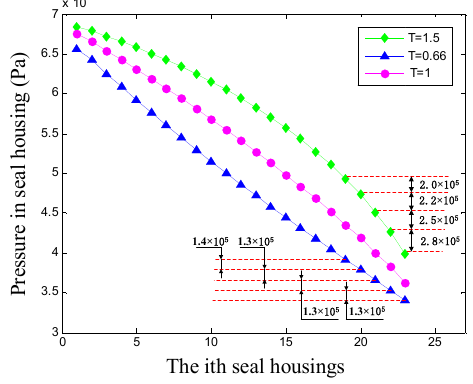
Figure 8. Pressure distribution features of taper clearance damper seals.